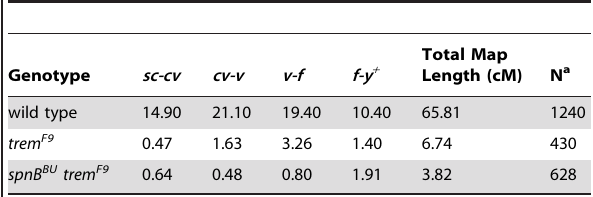
Table 10. Frequency of crossing over on the X chromosome in trem F9 females in the presence of a DNA repair